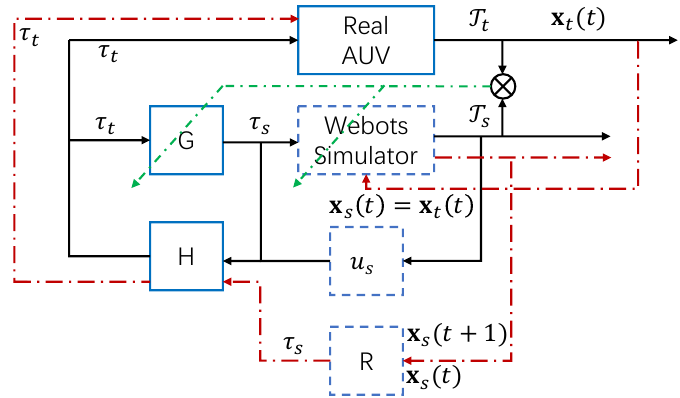
Figure 6. Transfer process between the source controller and target